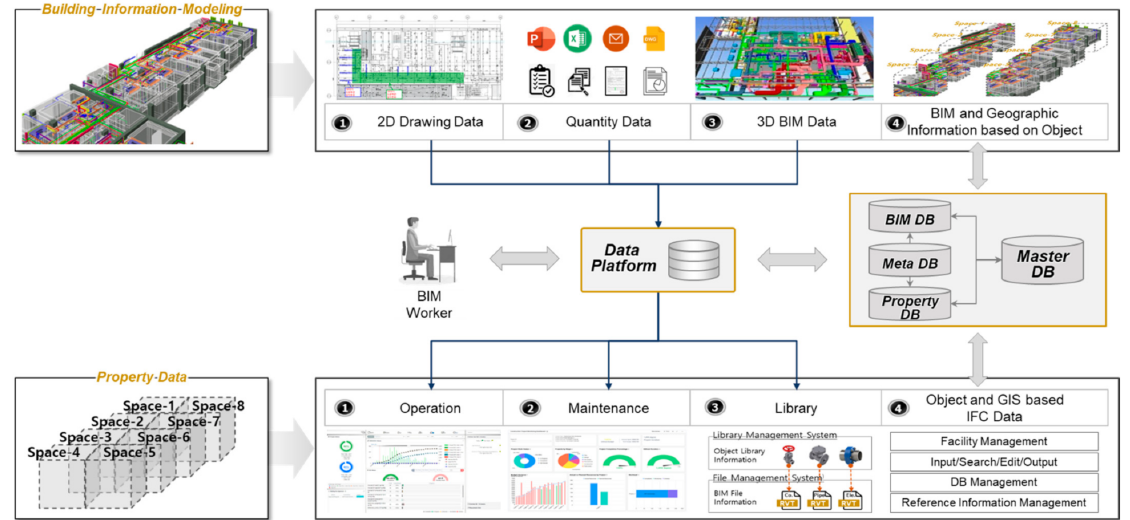
Figure 3. BIM and GIS-based working system configuration